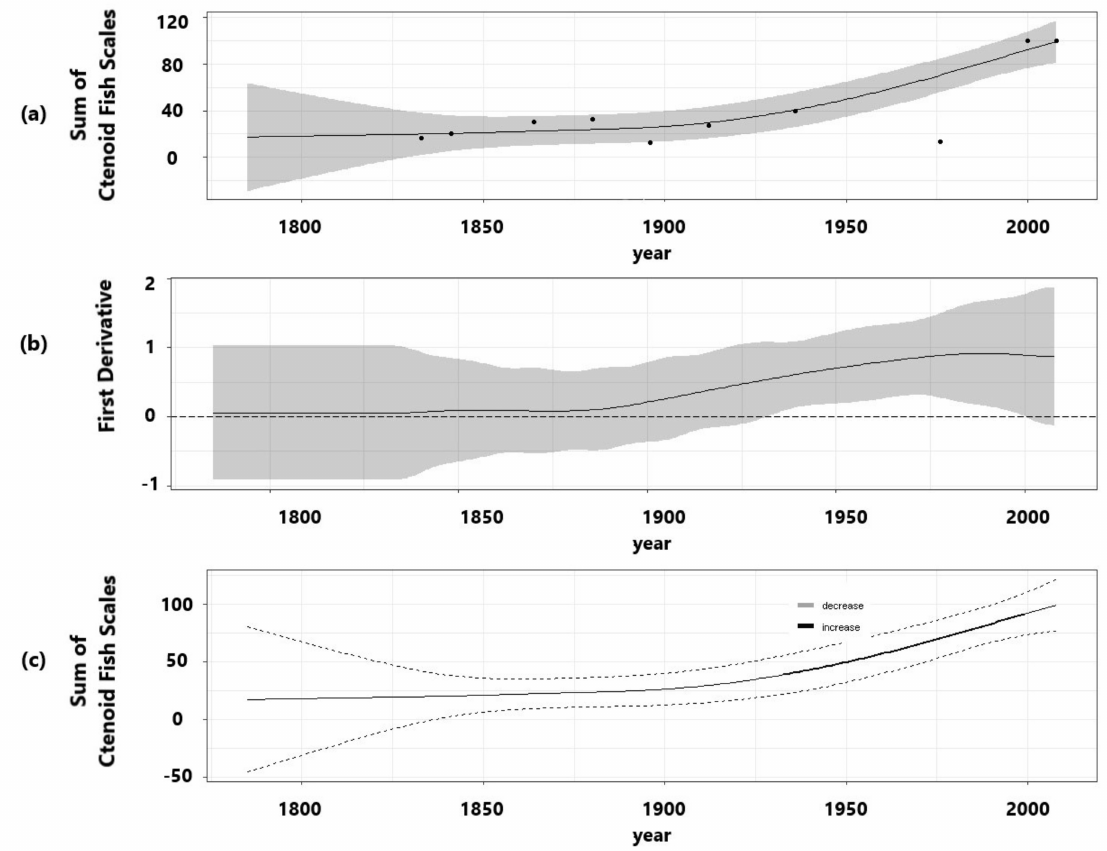
Figure 7. GAM fitted to the time series of fish scale abundance in the sedimentary archive of Lake Blanca Chica. ( a ) Observed values, GAM-based trend fitted and its simultaneous interval; ( b ) estimated first derivative of the GAM fitted trend and the 95% simultaneous interval; ( c ) period of